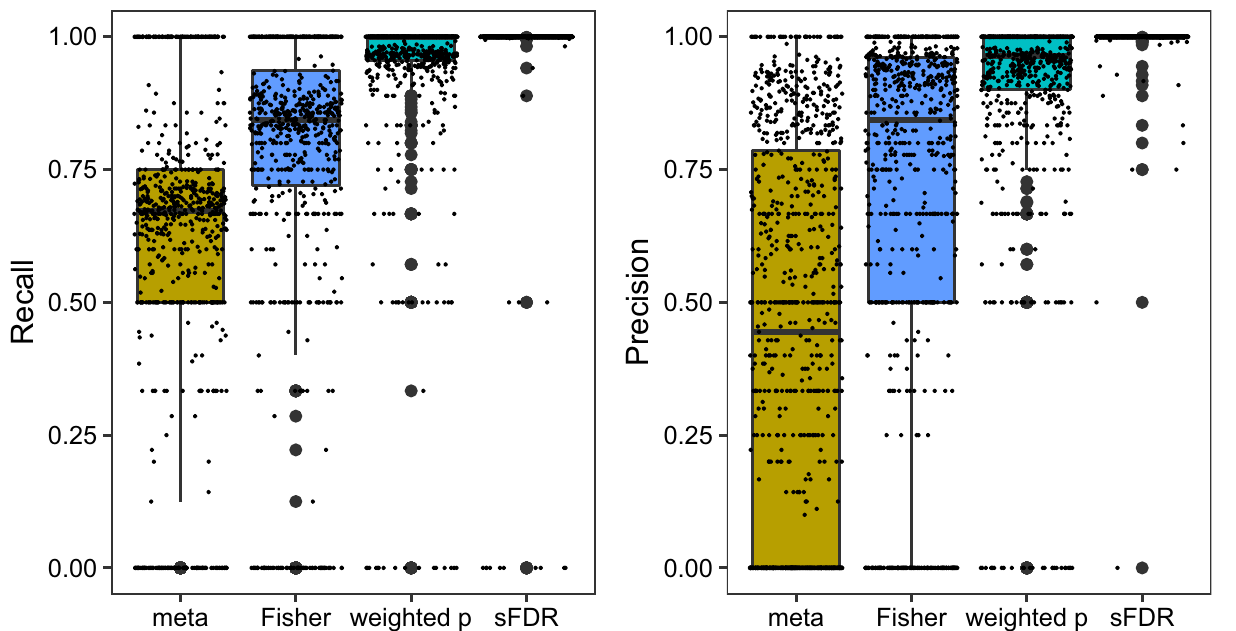
Figure 2. The Recall and Precision rates obtained from simulation study design II, integrating the 1132 UK Biobank GWAS summary statistics with permuted CADD functional meta-scores, using meta-analysis, Fisher’s method, the weighted p value approach, and the stratified FDR control. Recall t 1 Precision t FDR t TP t / P t , where m 1, t is the number of genome-wide significant independent loci = − = prior to data-integration for trait t , and P t and TP t are the numbers of positives and true positives after data- integration; see Table S2 for additional results. Independent loci were defined using PLINK’s LDclumping algorithm with a 1 Mb window and an r 2 threshold of